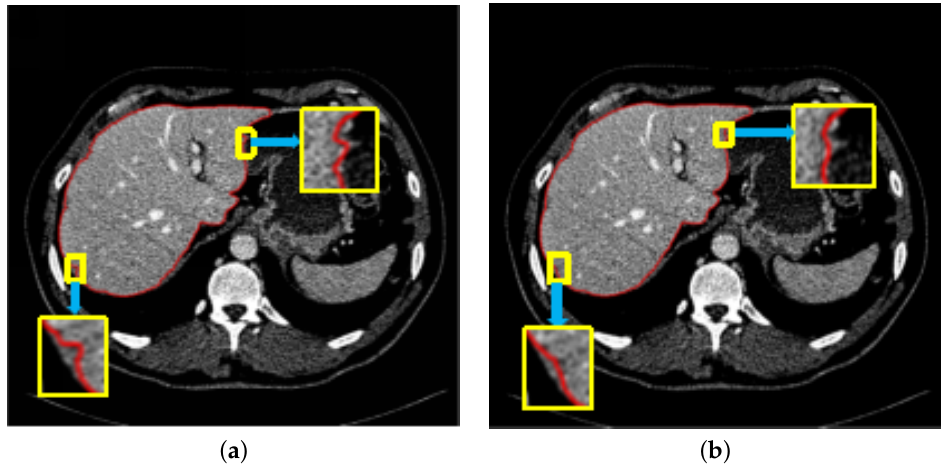
Figure 5. Comparison before and after using RD level set: ( a ) Segmentation effect before using RD level set. ( b ) Segmentation effect after using RD level